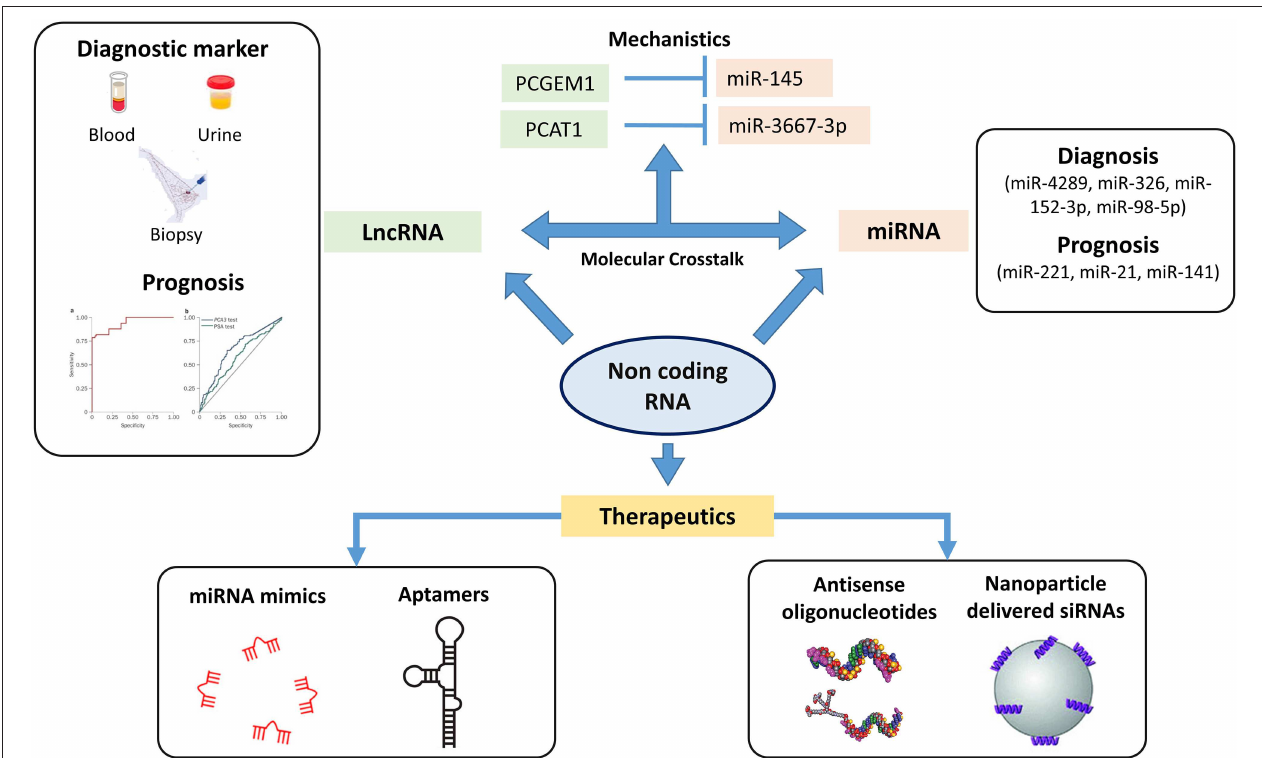
FIGURE 3 | Non-coding genome plays an important role in oncogenesis. The figure highlights the different sets of non-coding RNA which can be used therapeutically as well for diagnosis and prognosis. MicroRNA (miRNA) profiles have been screened in identifying differences in localized and metastatic form of prostate cancer (PCa) with studies also targeting these miRNAs as therapeutics. Long non-coding RNA (lncRNA) including PCA3 and second chromosome locus associated with prostate-1 (SChLAP1) have been screened as potential prognostic markers wherein a PCA3 test has already been FDA recognized as urinary diagnostic biomarker. The crosstalk between these lncRNAs and miRNAs have been studied for identifying novel mechanisms in PCa pathogenesis. The figure highlights the crosstalk between lncRNA PCGEM1 and PCAT1 with miR-145 and miR-3367-3p. ASO and nanoparticle delivered siRNAs based therapeutics have entered the clinical trial stages wherein these non-coding RNAs have been targeted with small antisense oligos to inhibit/restore their activity ( ⊣ Inhibition).